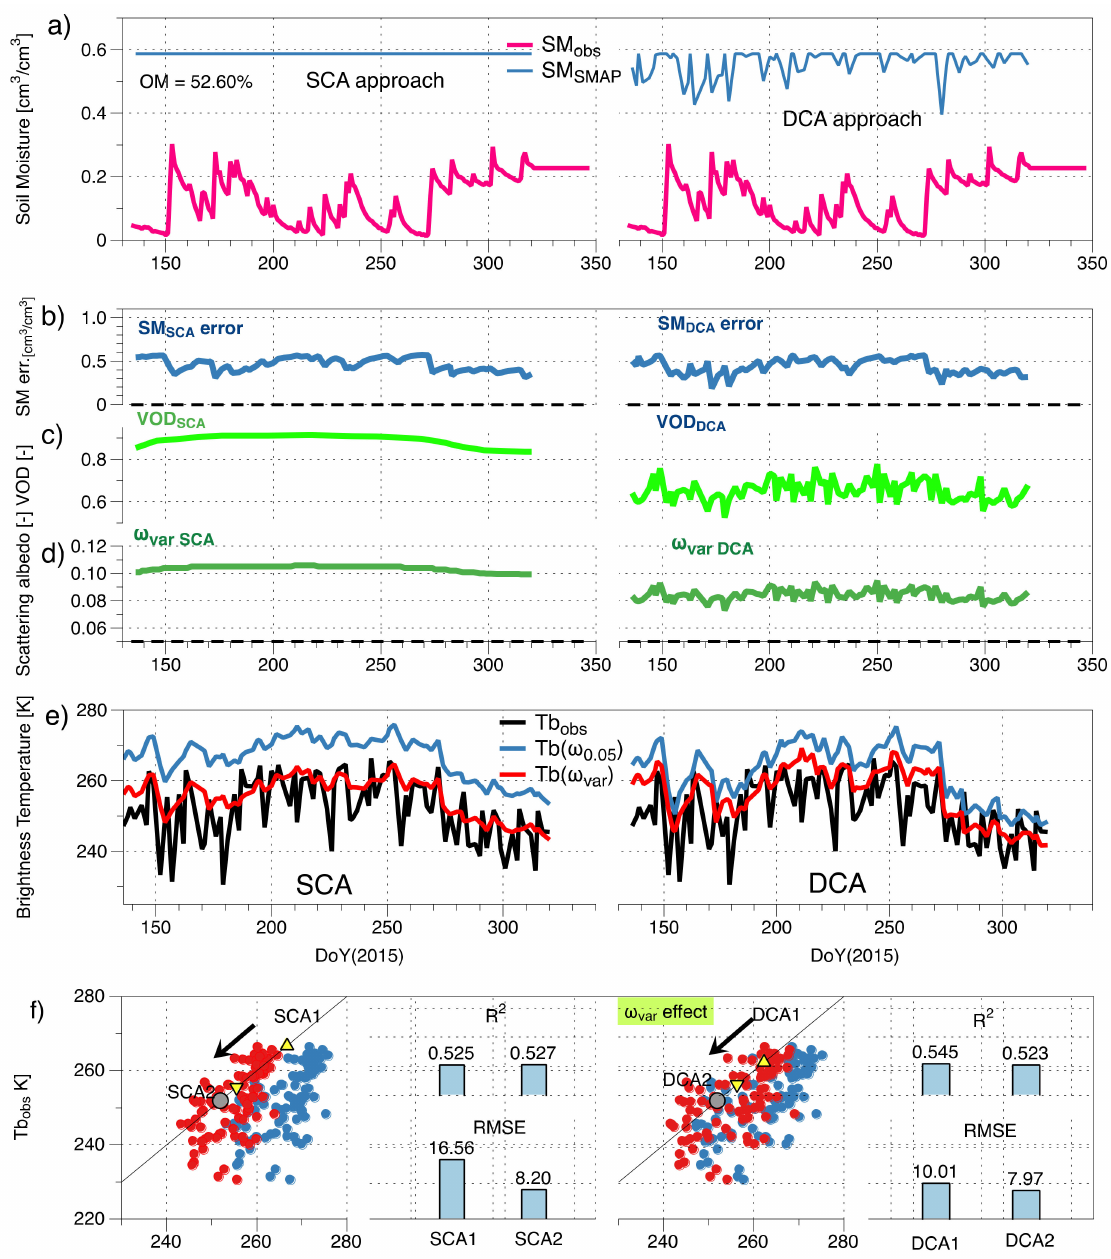
Figure 3. Validation of the improvement by applying time-varying ω within SCA and dual-channel algorithm (DCA) approaches; ( a ) the soil moisture estimation by SCA (left) and DCA (right), ( b ) their uncertainty, ( c ) SCA and DCA VOD, ( d ) the constant adapted by the Soil Moisture Active Passive (SMAP) algorithm and the proposed time-varying ω . ( e ) The brightness temperature simulated by τ - ω model applied with the constant and time-varying ω from ( d ) and the input of the in-situ soil moisture presented in ( a ) in the U.S. Surface Climate Observing Reference Network (USCRN) Durham-2-N (crop type: corn). ( f ) (cid:78) : mean SCA and DCA 1, (cid:72) : mean SCA and DCA2, • : mean SMAP Tb measurements, → : direction of change from mean SCA and DCA1 to SCA and DCA2 towards the reference